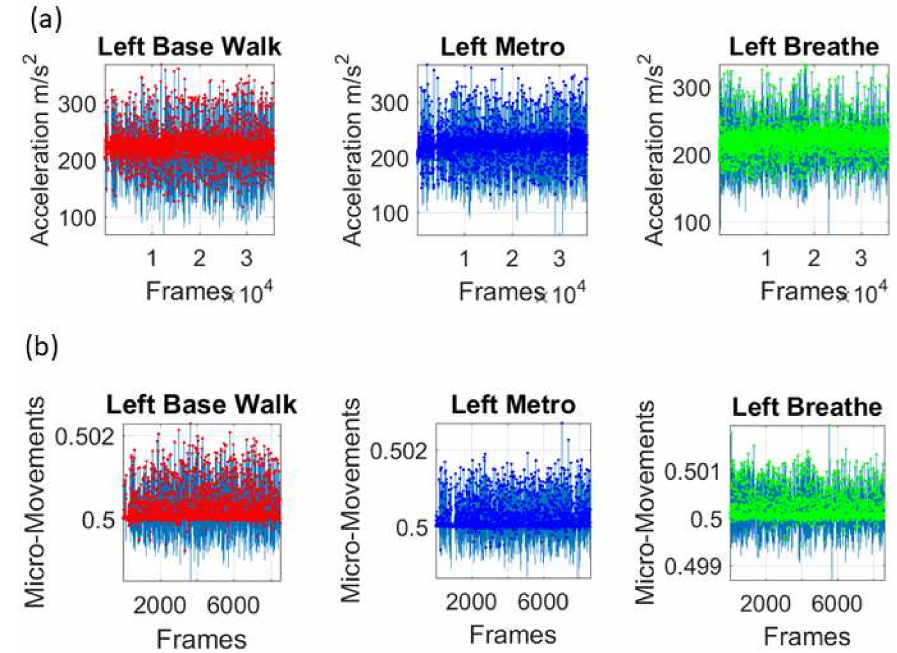
Figure 10. Comparison of subtle changes in walking patterns and levels of autonomous control using accelerometer data from the smart shoes Zeblok. ( a ) Raw data from each task (baseline walking: automatic; walking with a metronome in the background: spontaneous; walking with a metronome in the background while instructed to breathe to the metronome rhythms: deliberate). ( b ) Spike train micro-movements extracted from minute fluctuations in the peak